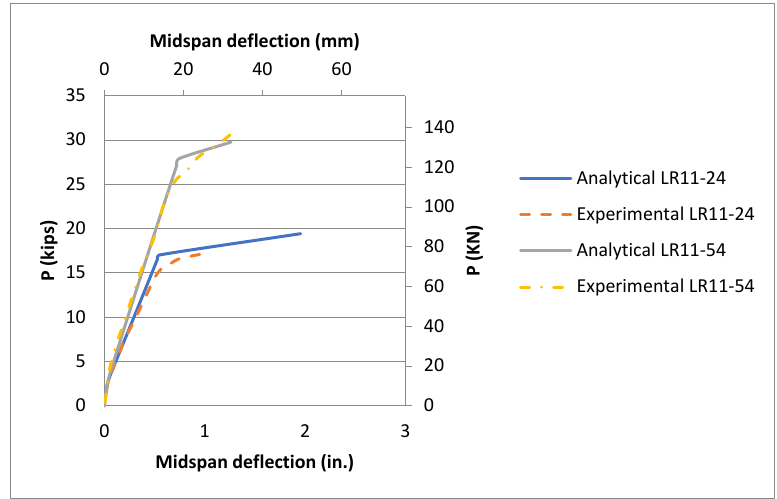
Figure 11. Ahmad and Barker (1991) [16] load vs. midspan deflection comparisons.